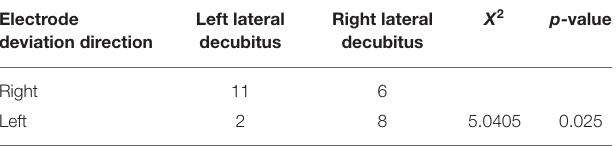
TABLE 2 | Electrode position and surgical position relationship.